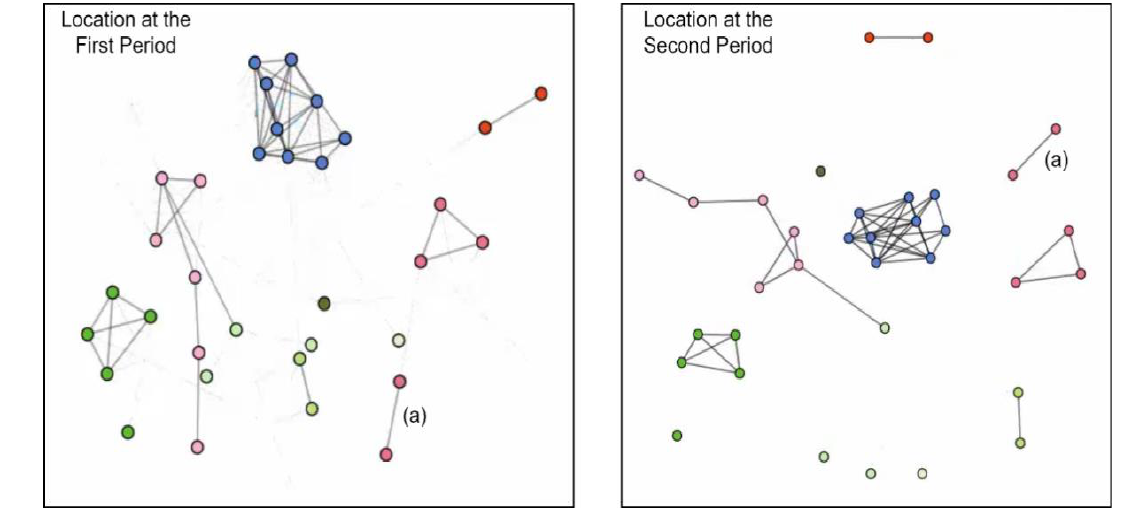
Figure 10. Transition from the first to the second period without any mental map preservation.